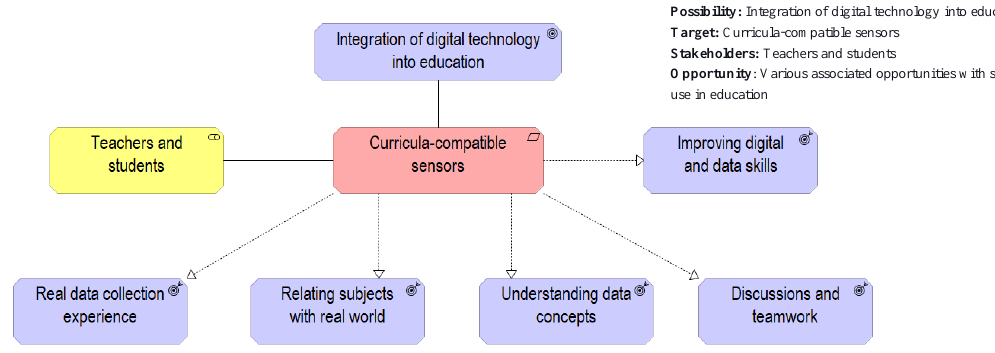
Figure 3. Associated opportunities with sensor use in education Table 3. Curricula-compatible sensor classes identified from the one-on-interviews and focus